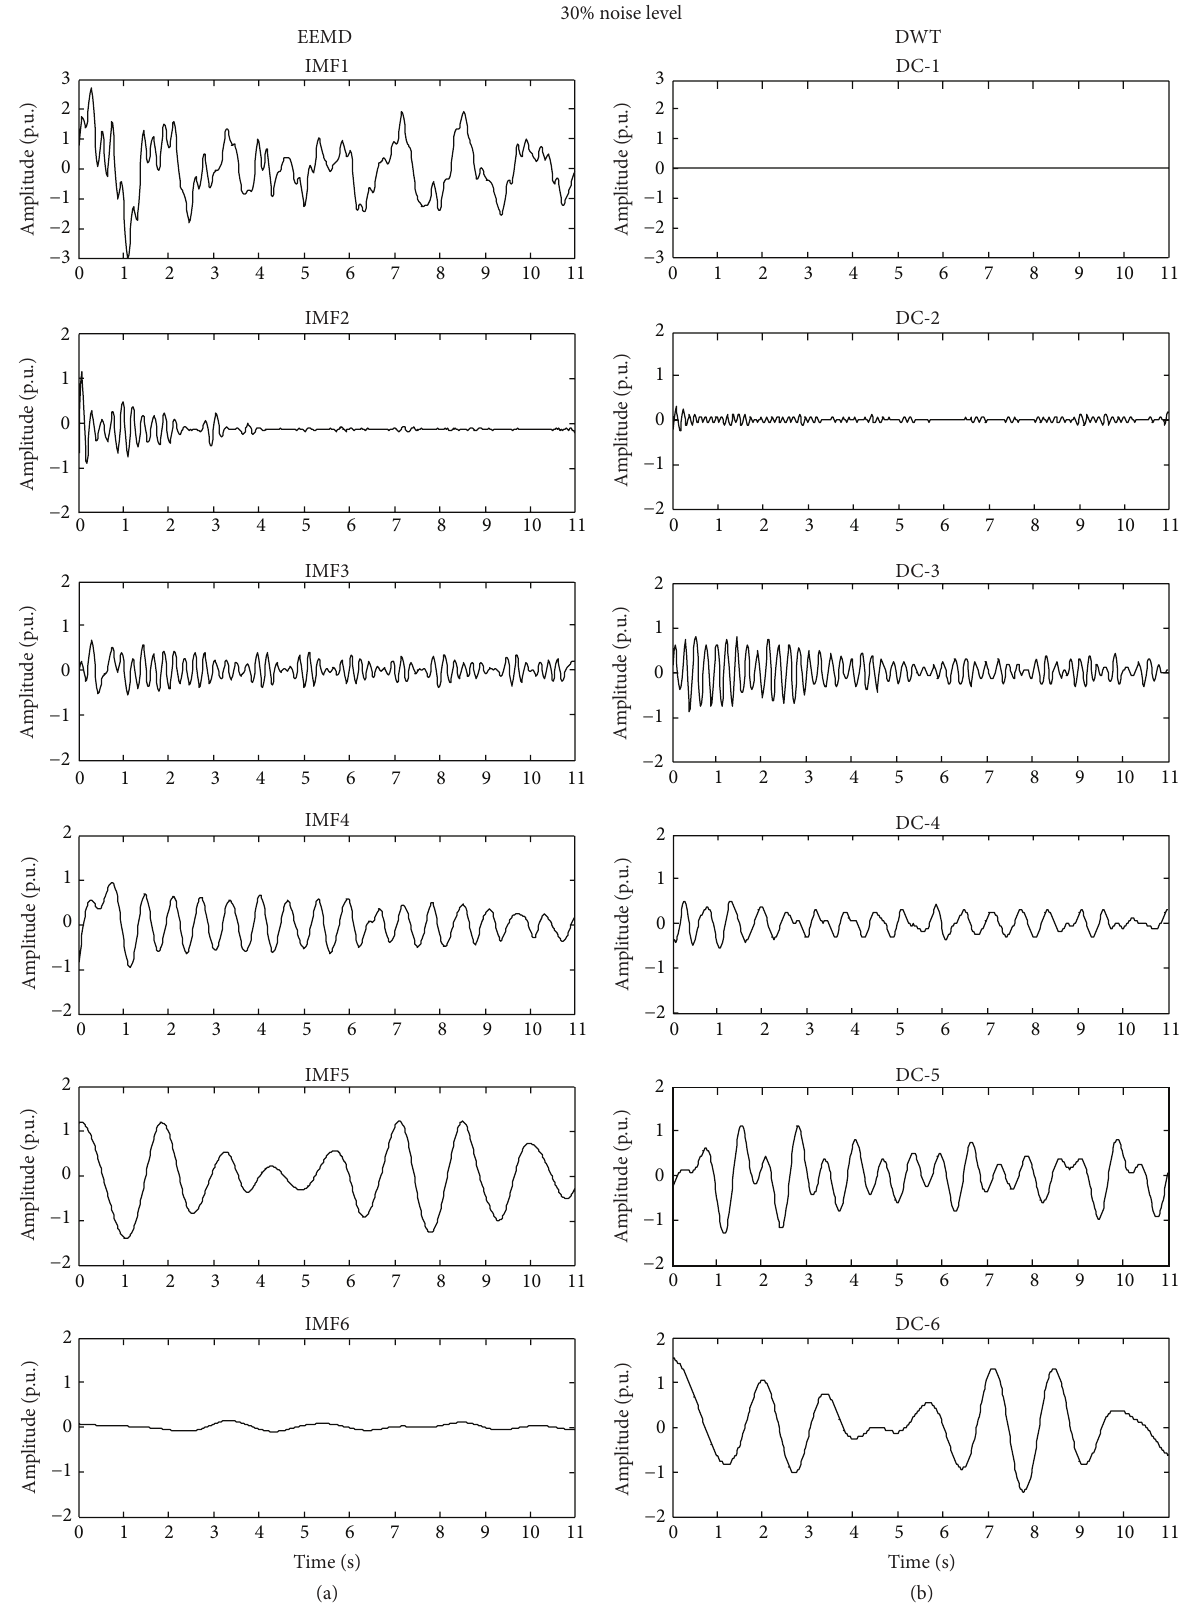
Figure 3: IMFs and DCs obtained of the synthetic signal through EEMD and DWT,